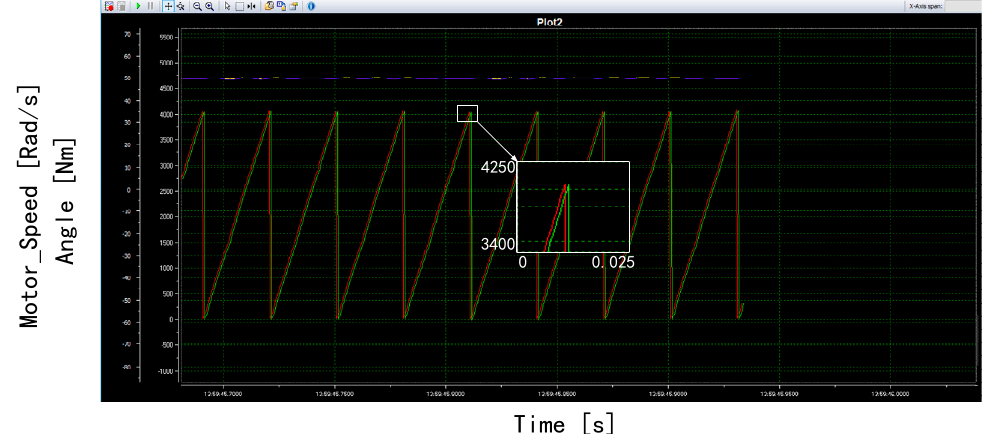
Figure 23. The comparison chart of the motor speed and rotor position of the new and improved SMO observer at 50 rad/s.